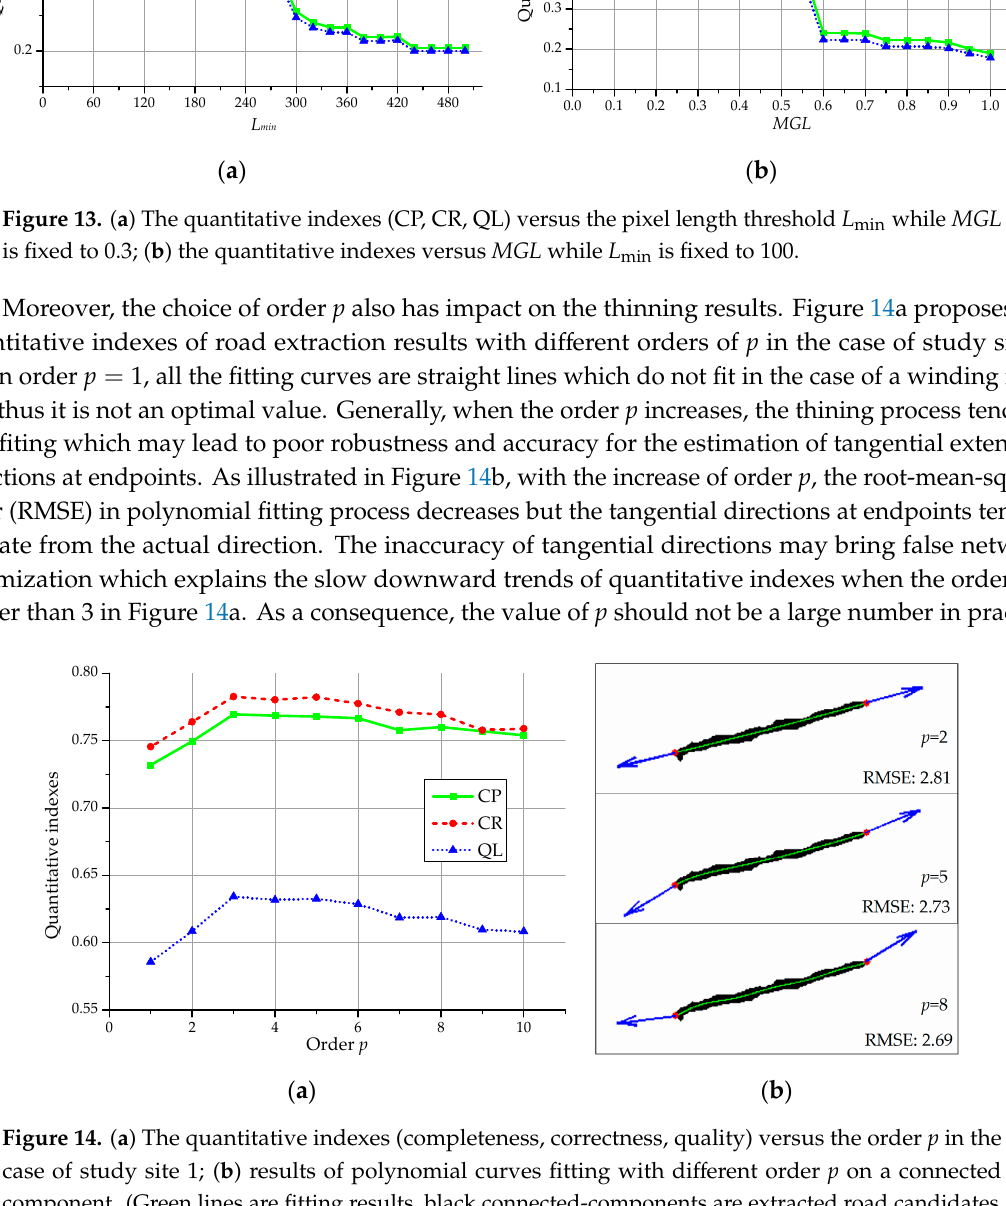
component. (Green lines are fitting results, black connected-components are extracted road candidates,